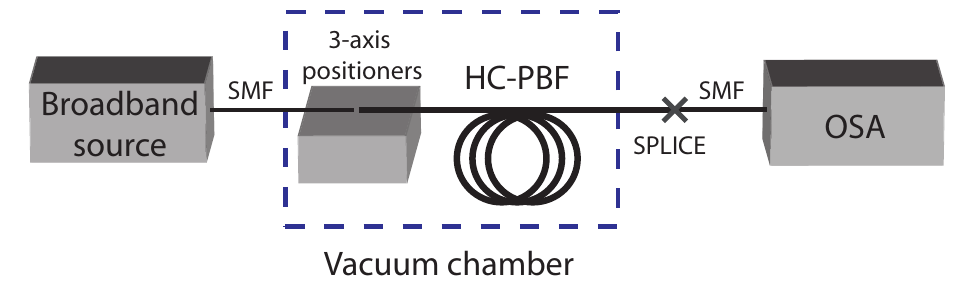
Figure 1. Experimental setup for methane detection experiments using a HC-PBF as gas